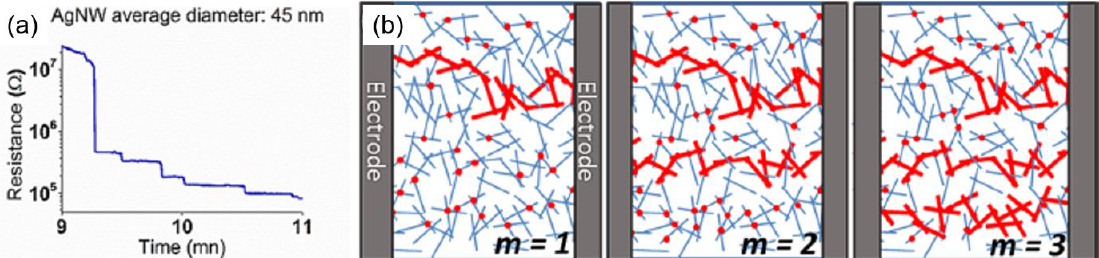
Figure 9. ( a ) Resistance curve for Ag NW networks under thermal ramp annealing (temperature history: ramping (20 ◦ C–100 ◦ C for 10 min) and holding (100 ◦ C for 1 h). ( b ) Scheme for the activation of e ffi cient percolation pathways via thermal annealing. Reproduced with permission from [40]. Copyright 2016 American Chemical